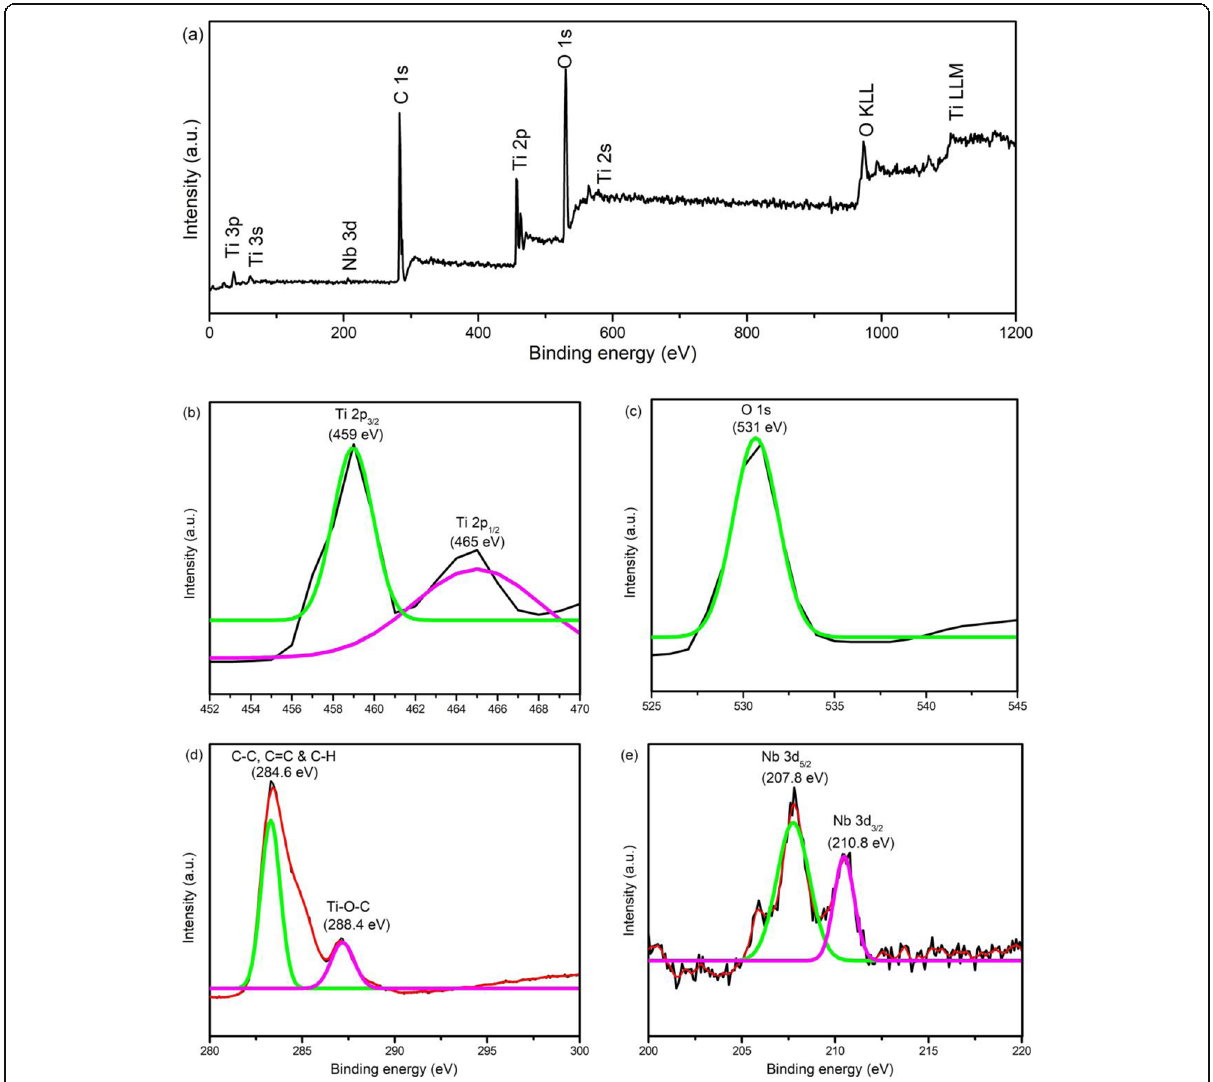
Fig. 6 XPS spectra of NTG5 (a) Full range spectra, (b) Ti 2p spectra, (c) O 1 s spectra, (d) C 1s spectra and (e) Nb 3d